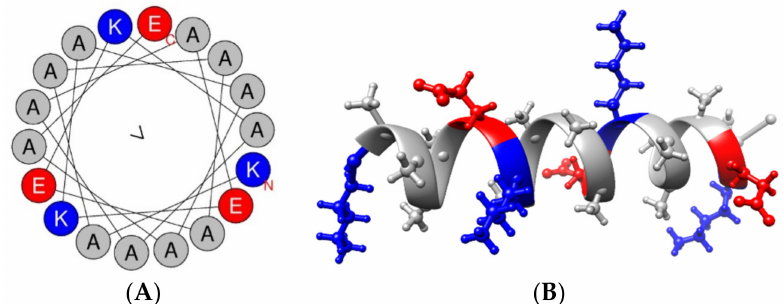
Figure 13. ( A ) Helical wheel of PepB 3 generated using Heliquest. The base peptide sequence has a zero-net charge and hydrophobic moment. ( B ) Folding of Ac-PepB 3 into an α -helix was predicted using PEP-FOLD3. For visualization, UCSF Chimera software [61] was